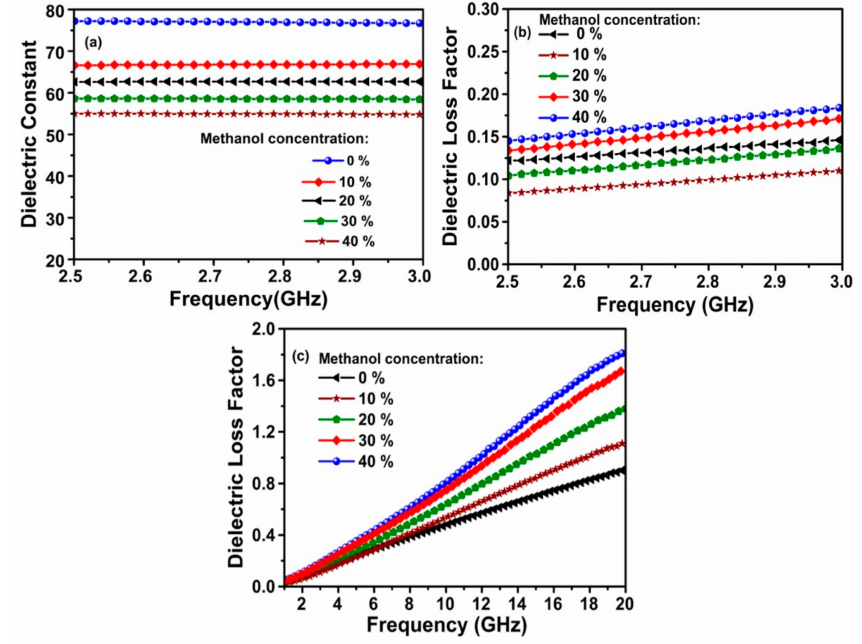
Figure 8. Measured results for methanol–water mixture: ( a ) the dielectric constant; ( b ) dielectric loss at